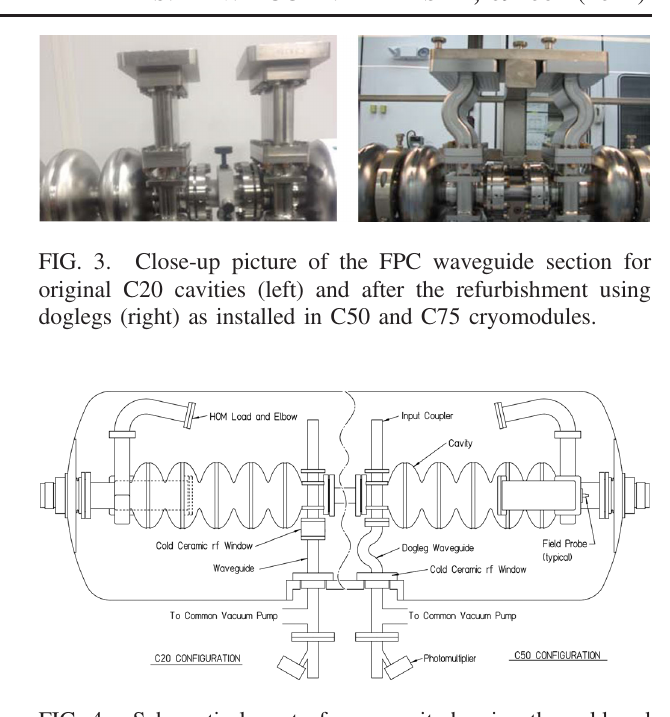
FIG. 4. Schematic layout of a cryounit showing the cold and warm rf ceramic window locations within a CM for both a C20 CM configuration and a C50 or C75 CM configuration.